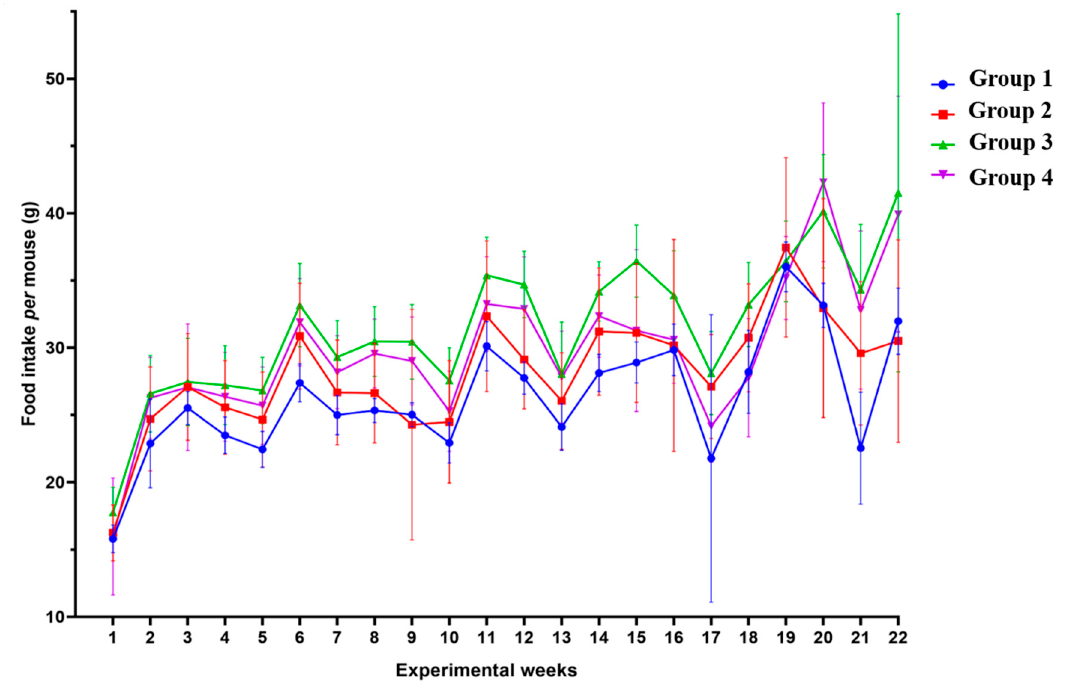
Figure 9. Weekly food intake per mouse by group. During the 22 weeks of the experiment (DMBA application from Week 1 until Week 17 of the experiment), it seems that the HPV + mice (Groups 3 and 4) had a higher consumption of food (per mouse) than the HPV − ones (Groups 1 and 2). However, there only exists a statistically significant di ff erence between Groups 1 and 3 ( p < 0.01). Group 1: HPV − without DMBA application ( n = 10); Group 2: HPV − with DMBA application ( n = 10); Group 3: HPV + without DMBA application ( n = 10); Group 4: HPV + with DMBA application ( n =